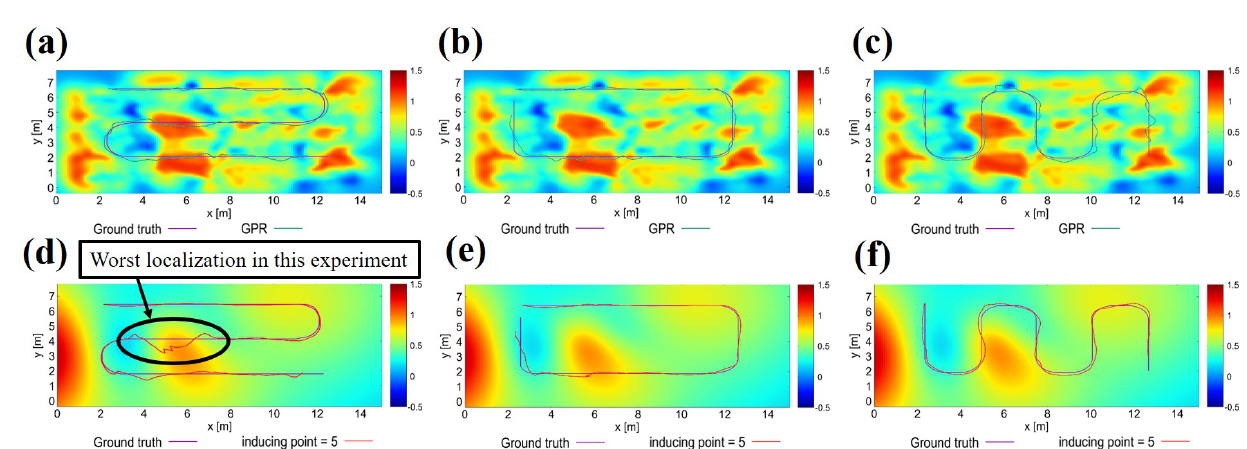
Figure 10. Experimental results of localization. Magnetic map created by GPR and SGPR is displayed as a two-dimensional color map, and each specified route and the trajectory of localization are superimposed. ( a – c ) and ( d – f ) show the results of localization for each specified route using the maps created by GPR and SGPR,